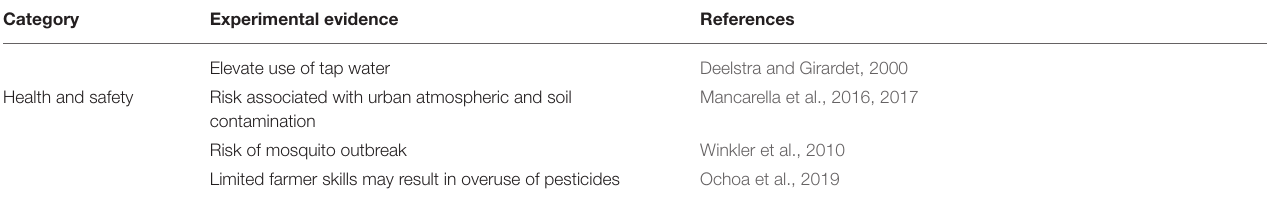
TABLE 2 | Estimated and potential contribution of UA to food security in world cities.